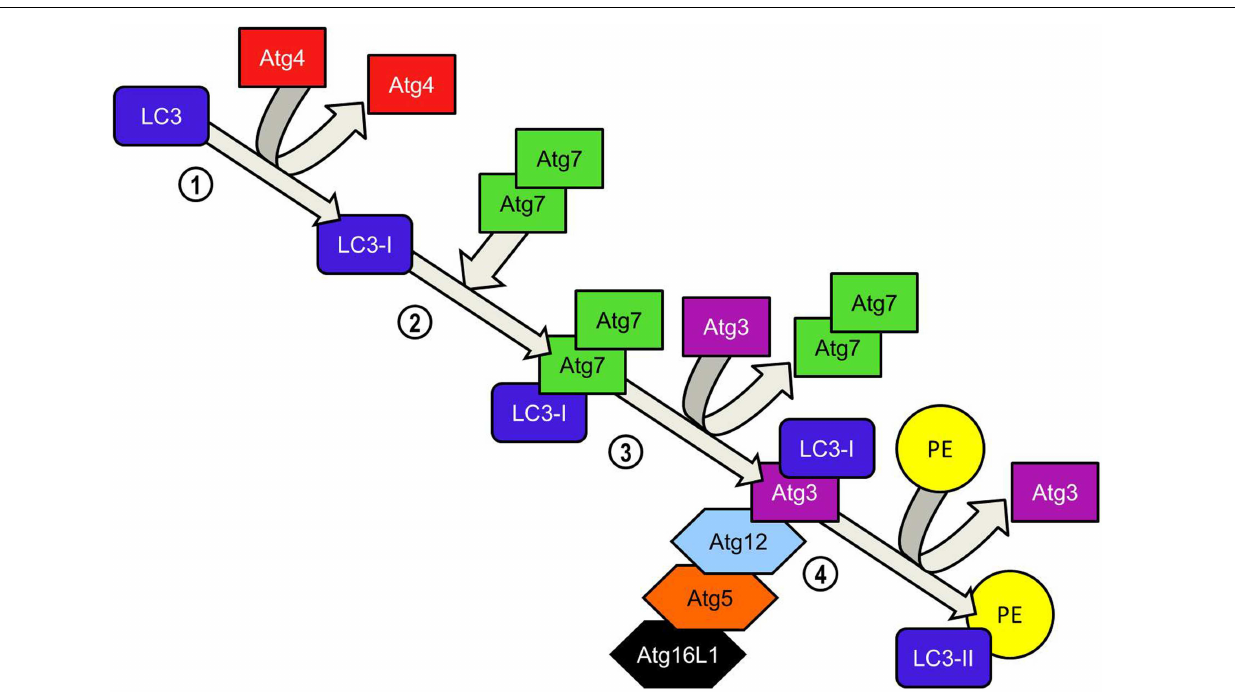
formed when LC3-I is conjugated to the lipid phosphatidylethanolamine (PE) in a reaction catalyzed by Atg3. Binding of the Atg5-Atg12-Atg16L1 to Atg3 enhances the lipidation of LC3-I.The ability of the Atg5-Atg-12 complex to bind PE already inserted into the isolation membrane ensures that newly converted LC3-II is incorporated into the elongating isolation membrane. Unlike the formation of the Atg5-Atg12 complex, the conversion of LC3-I to LC3-II is reversible. Atg4 cleaves PE from LC3-II and LC3 is recycled.